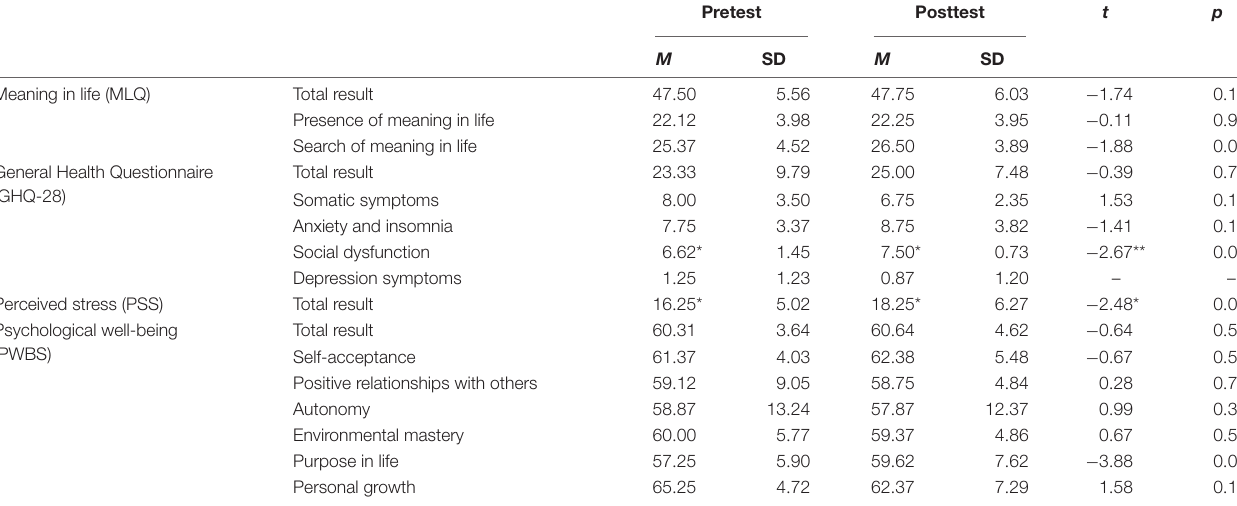
TABLE 3 | Comparison of the level of meaning in life, general health, perceived stress and psychological well-being before (pretest) and after a week (posttest) in control group (without intervention) ( n = 40).